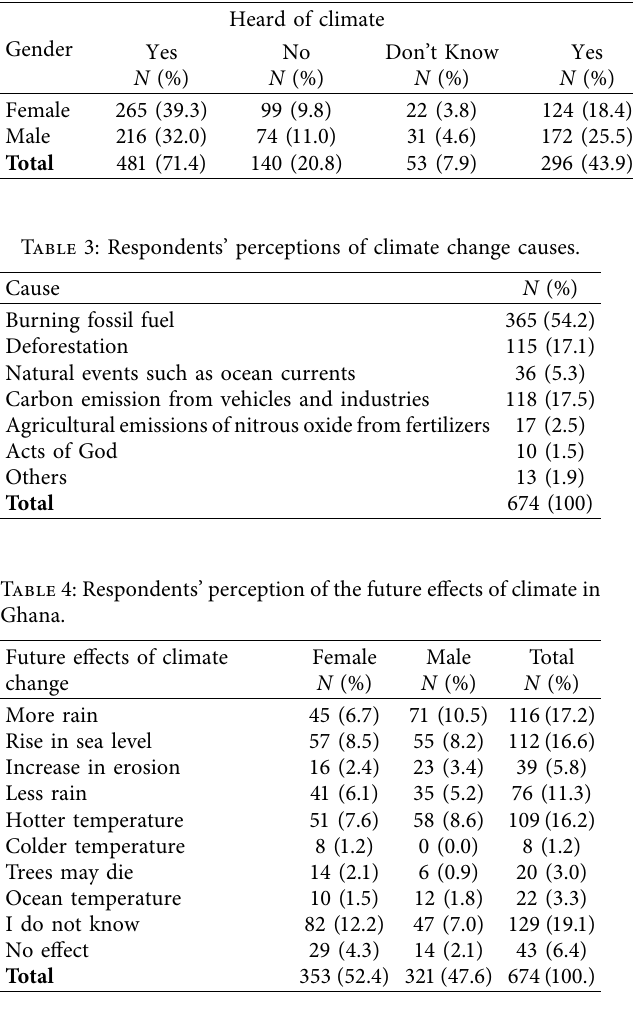
Table 2: Respondents’ understanding of climate change.